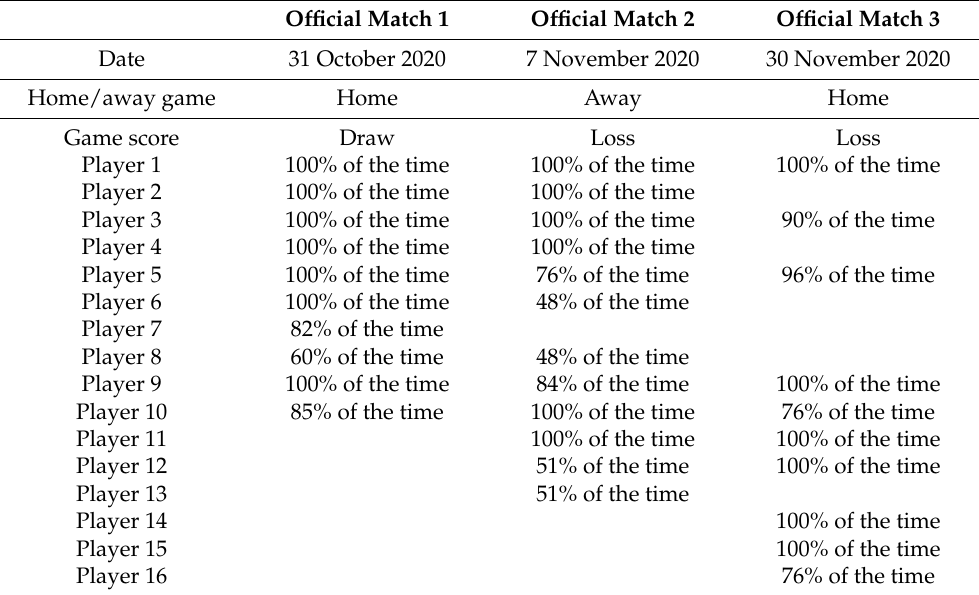
Table 1. Players’ individual descriptive of the official